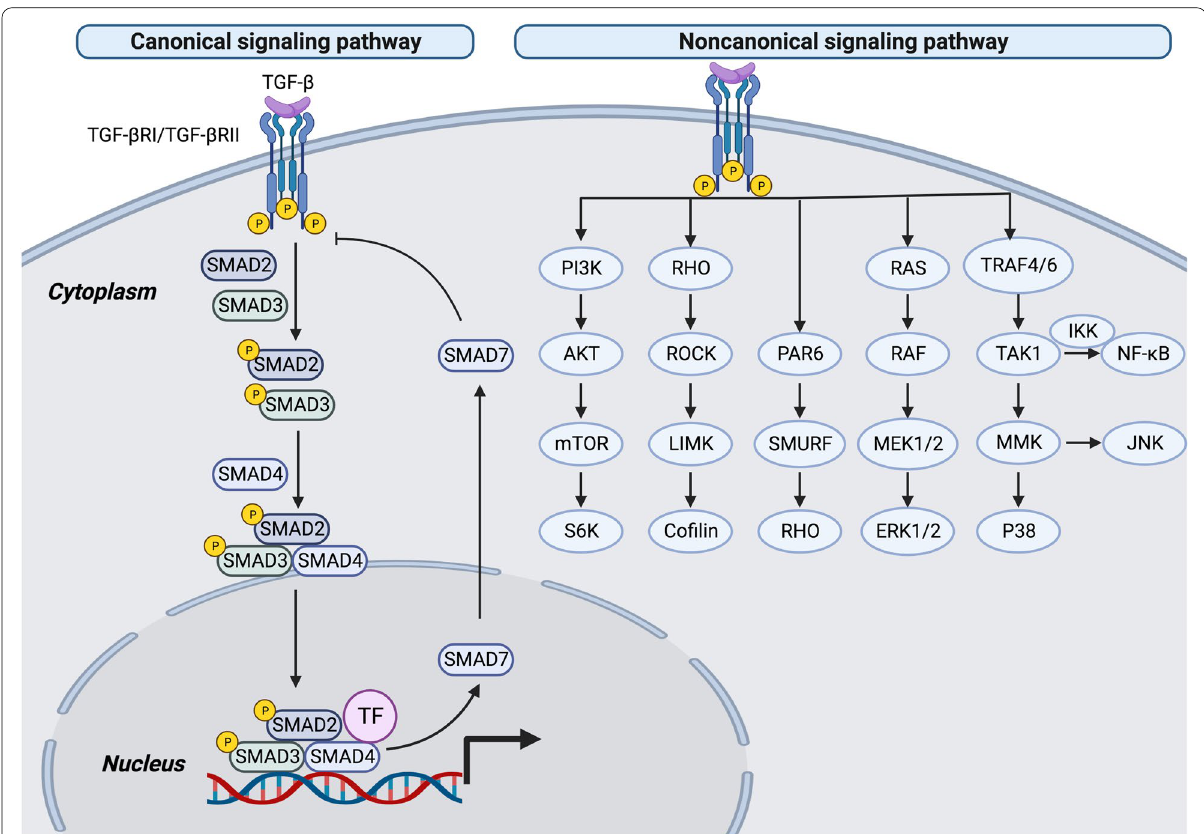
Fig. 2 TGF-β induced canonical and noncanonical signaling pathways. TGF-β is presented to TGF-βRII, which phosphorylates TGF-βRI to initiate the subsequent TGF-β pathway. In the canonical pathway, TGF-βRI phosphorylates SMAD2/3 to form the SMAD2/3-SMAD4 complex. SMAD2/3, SMAD4 and transcription factor (TF) complexes are transferred to the cell nucleus, modulating the expression of target genes. SMAD7, one of the target genes, regulates the duration and intensity of TGF-β with a negative feedback loop. In the noncanonical pathway, TGF-β can activate PI3K, RHO, PAR6, RAS, TRAF4/6, JNK, P38, NF-κB and ERK